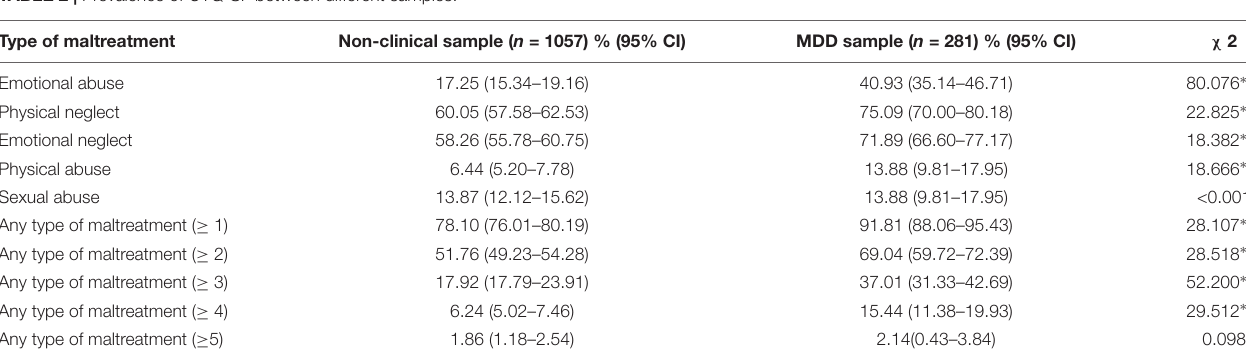
TABLE 2 | Prevalence of CTQ-SF between different samples.